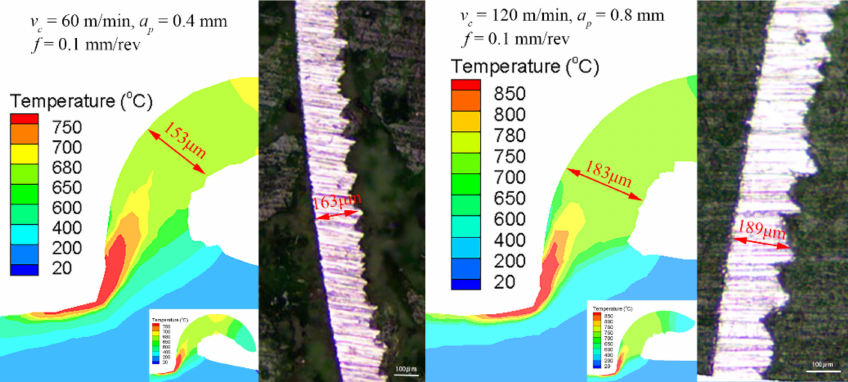
Figure 5. The comparison of the chip thickness in the experiments and simulations [28].